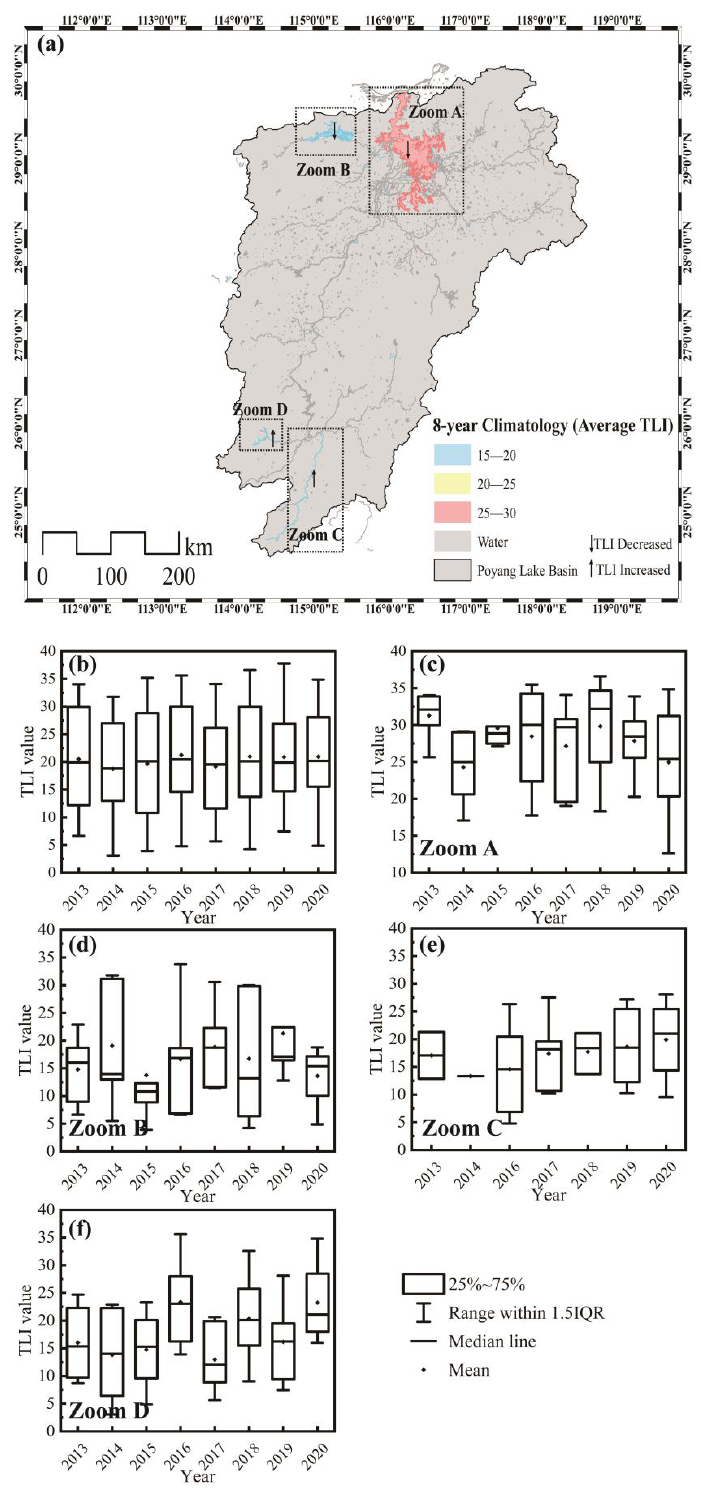
Figure 7. ( a ) Spatial distribution of climatological TLI for the four studied regions on the Poyang Lake Basin (PLB) from the Landsat-8 OLI observations. The annotations “ ↑ ” and “ ↓ ” represent statistically significant increasing and significant decreasing trends, respectively. Subpanels A to D shows the four studied regions, respectively. ( b ) represent the variations in annual mean TLI in Poyang Lake Basin. ( c – f ) represent the variations in annual mean TLI in Poyang Lake, Zhelin Reservoir, Tao River, and Yangming Lake,